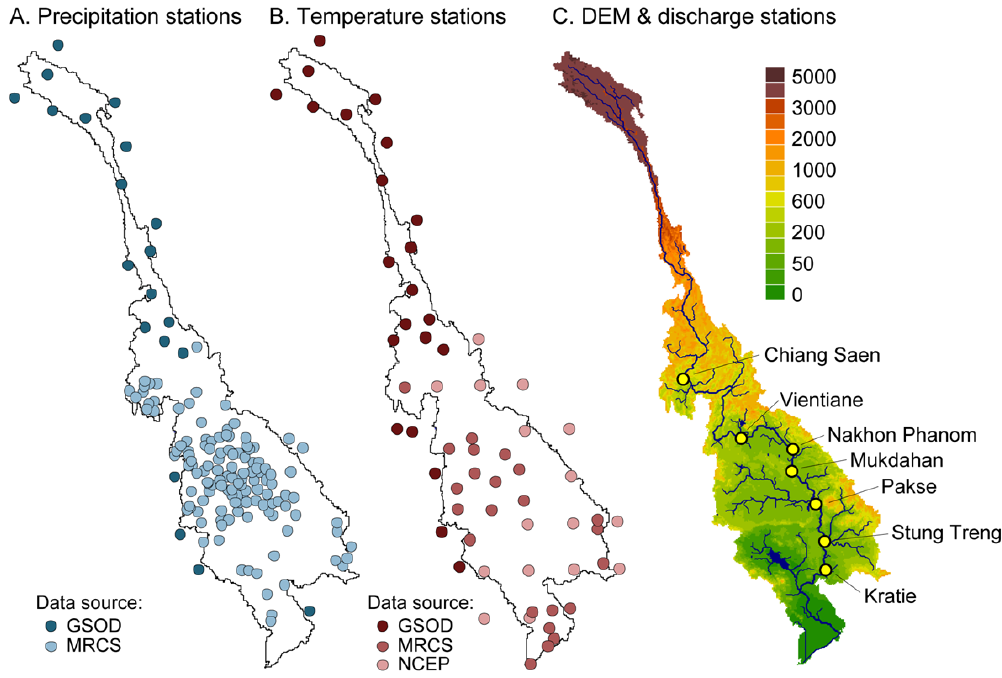
Fig. 1. Location of the hydrometeorological stations used in the study. (A) precipitation stations; (B) temperature stations; (C) main river discharge gauging stations over the DEM (digital elevation model). GSOD stands for Global Surface Summary of Day data (NCDC, 2010); MRCS stands for Mekong River Commission hydrometeorological database (Mekong River Commission, 2011); and NCEP for NCEP-DOE Reanalysis 2 data (NOAA,